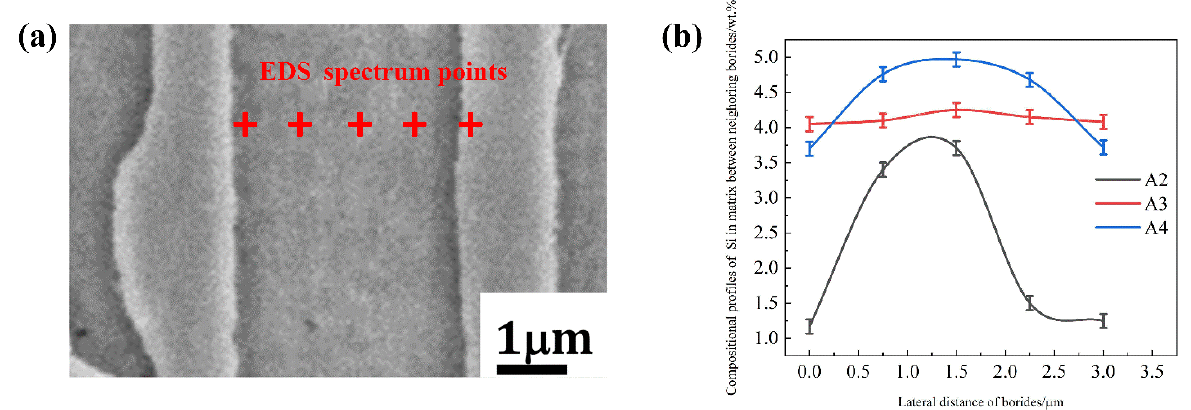
Figure 9. Point scanning analysis of as-cast DS Fe-B alloy: ( a ) schematic map of the Si point scan- ning of A3 specimen, ( b ) compositional profiles of Si in matrix between neighboring borides.